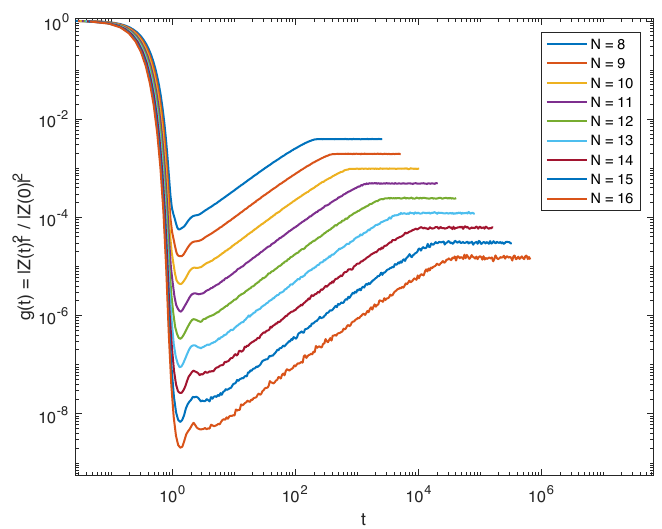
Figure 6 . The spectral form factor for the k -local randomly coupled qubits (RCQ) with 8 to 16 qubits. We observe the Gaussian decay at the early times, follow by a ‘bump’, ramp and plateau.